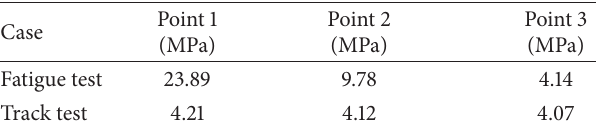
Figure 14: Changes in principal stress in track test (Point 1). Table 4: Comparison of equivalent stress range in fatigue test and track test.